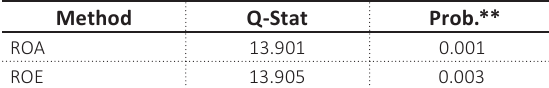
Table 3. Q -Stat autocorrelation test